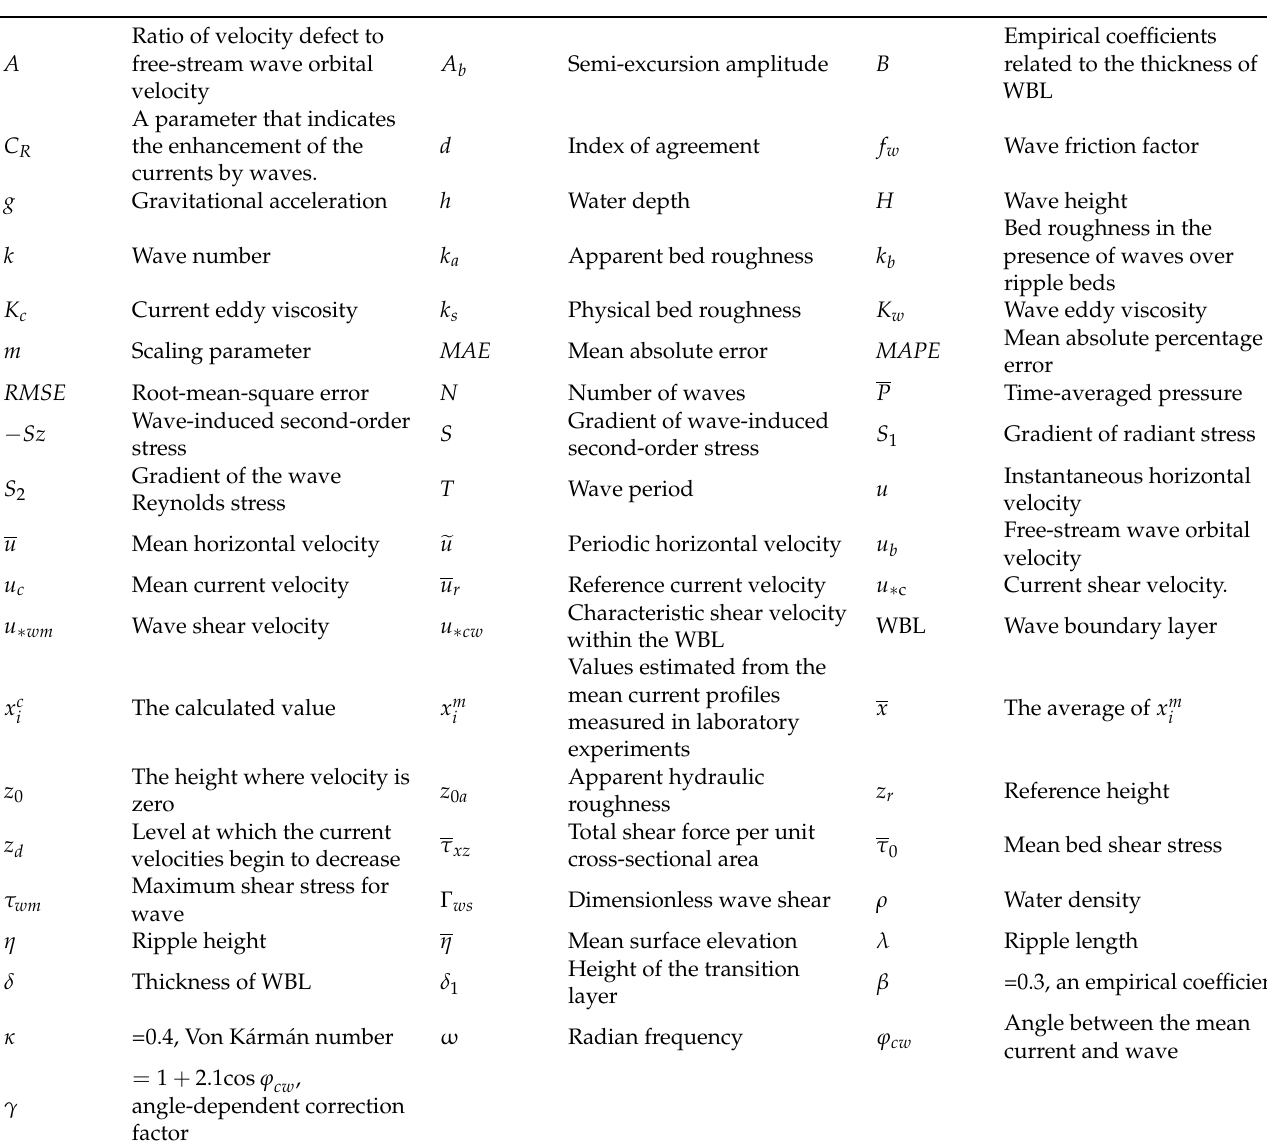
Table 5. List of